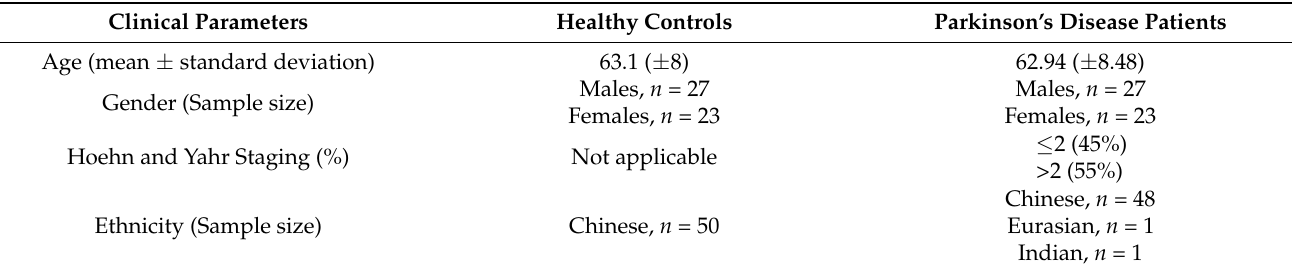
Figure 2. STIP1 autoantibody titres in the Parkinson’s disease patients and healthy controls. Plasma samples from the Parkinson’s disease (PD) patients and healthy controls (HC) ( n = 50 per group,